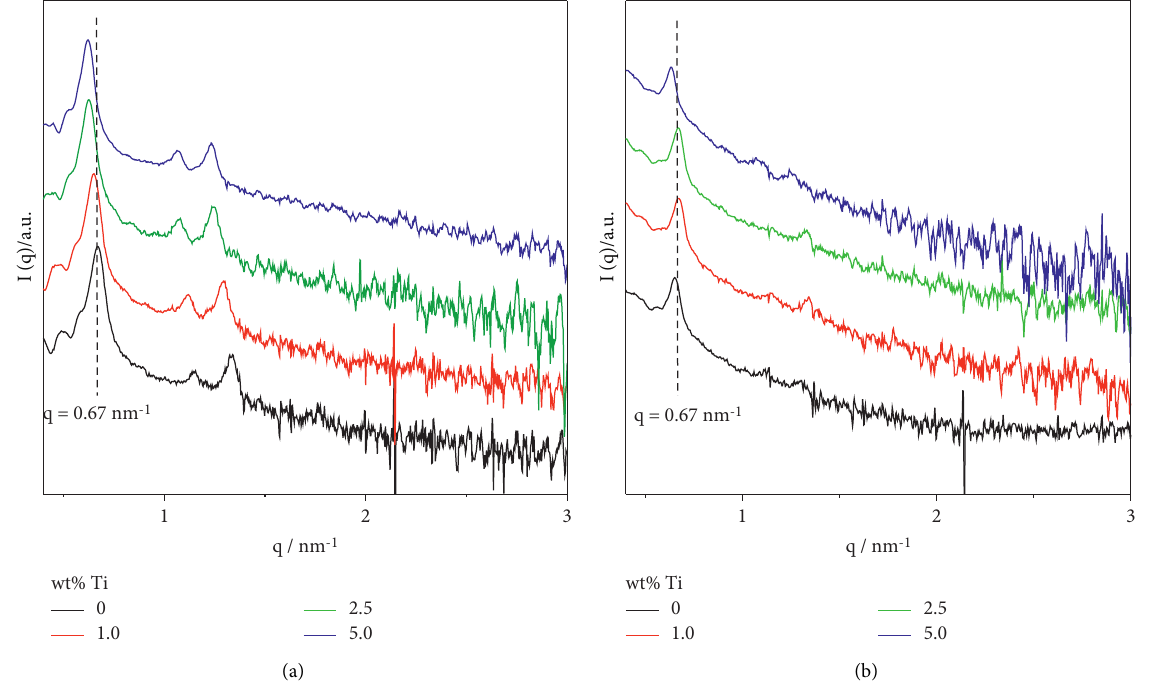
Figure 1: SAXS patterns of (a) xTi-SBA-15 and (b) xTi-SBA-15/C